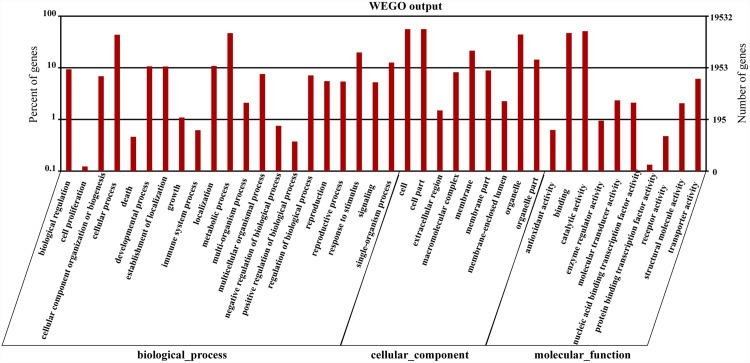
GO categories for the genes identified. Y-axis (left) represents the percentage of genes identified in this study; Y-axis (right) represents the actual gene number.The genes were annotated into three main categories: biological process, cellular component and molecular function (X-axis).